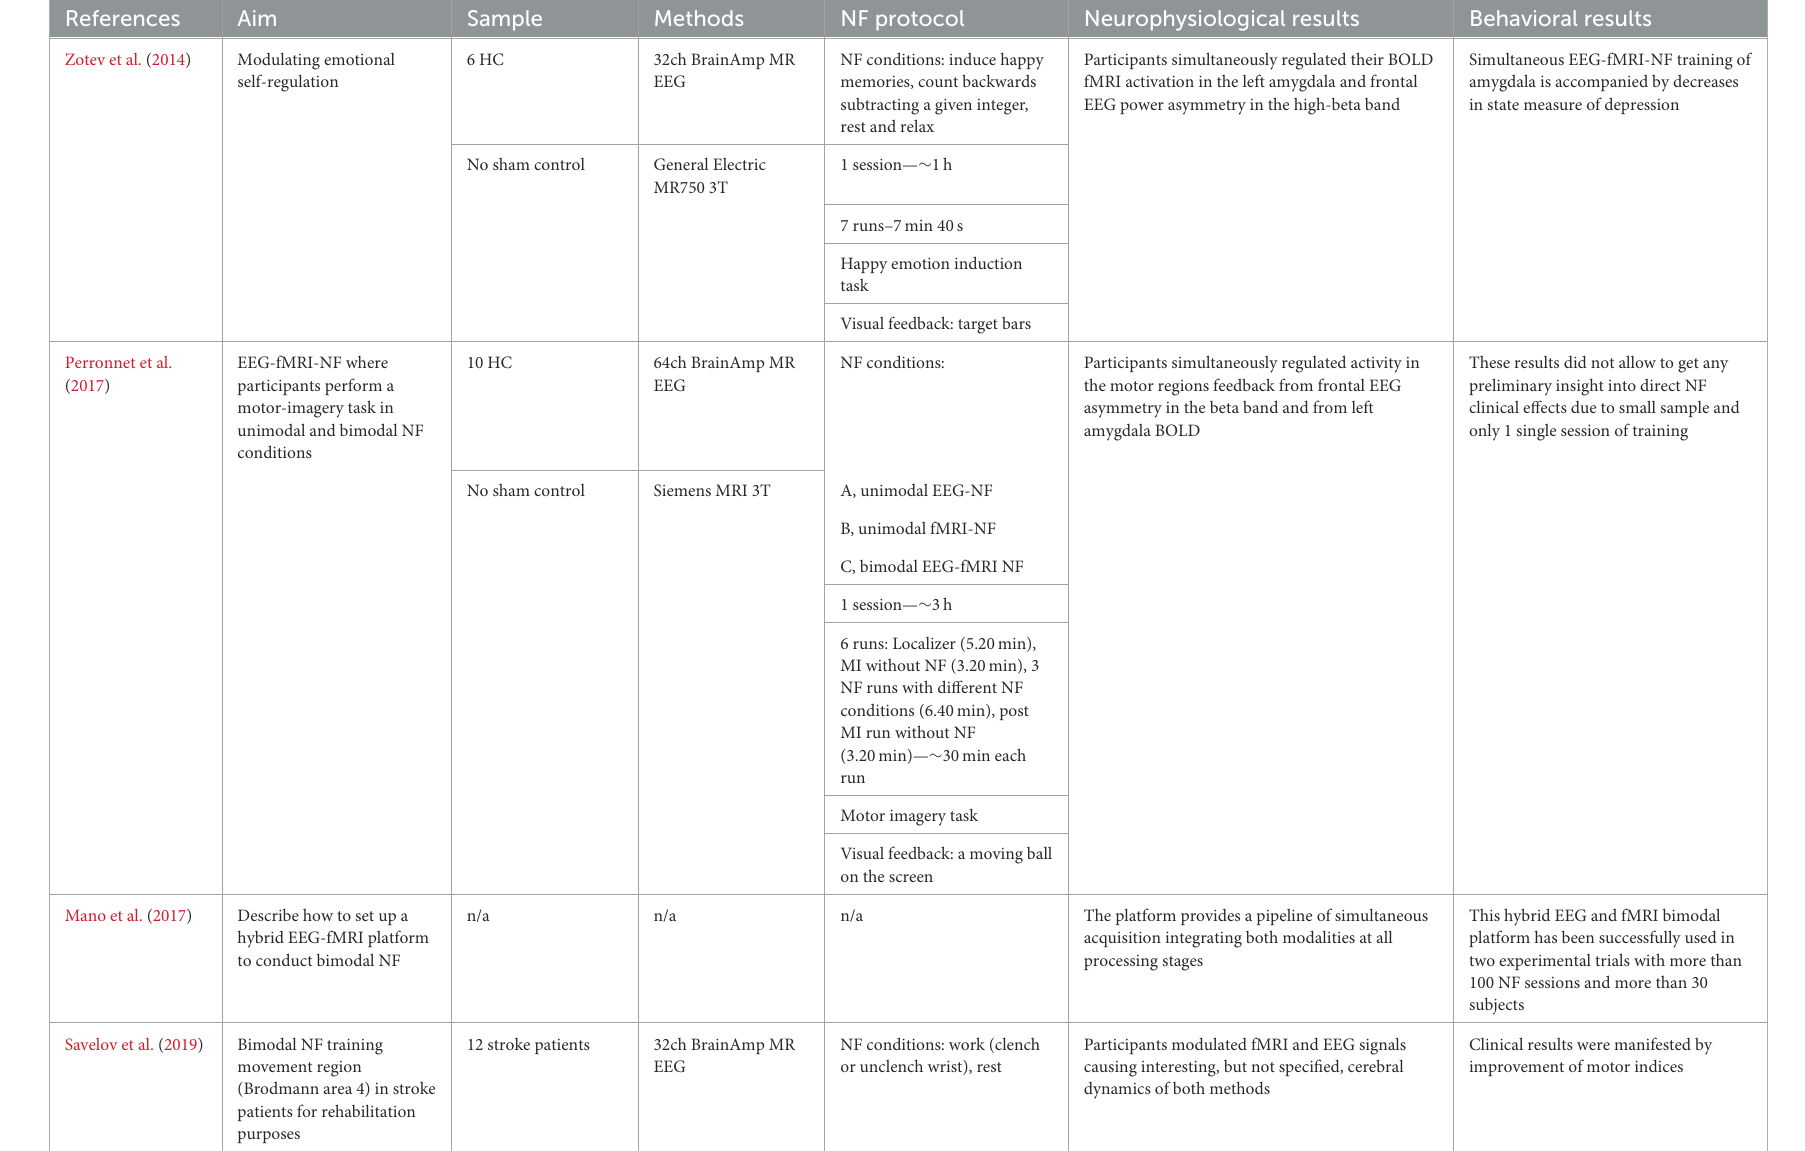
TABLE 1 Ten EEG-fMRI-NF studies included in the review, organized by: authors, aim of the study, sample, methods, NF protocol, neurophysiological results and behavioral